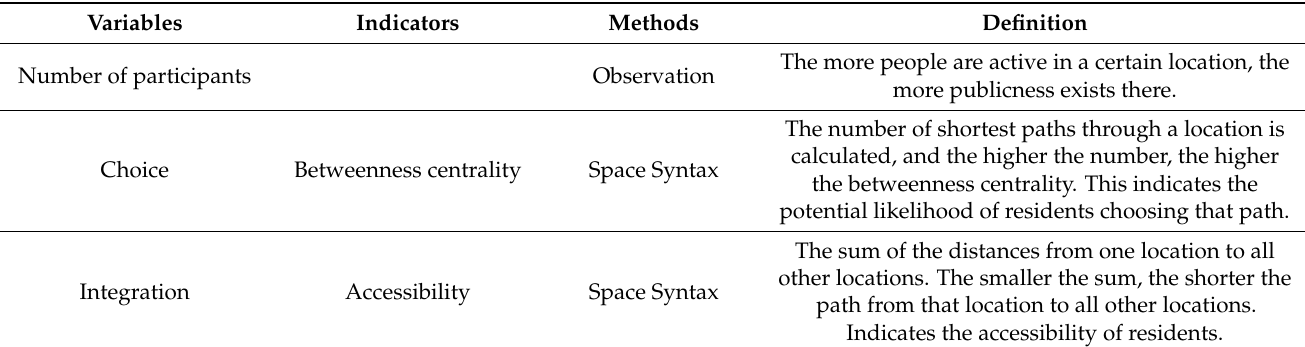
Table 1. Indicators and definitions of spatial publicness